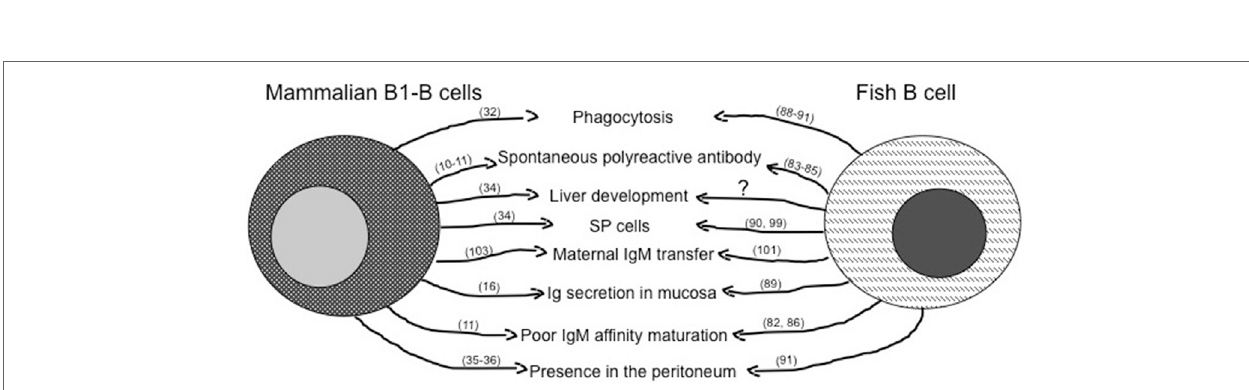
FigURe 1 | Similarities between mammalian innate-like T lymphocytes and fish T cells. The figure reassumes similar immune activities of γδ T innate-like T cells as they are known in mammals and in fish. The question mark represents activities likely present, but not fully demonstrated yet. Main references for the indicated activities are reported in